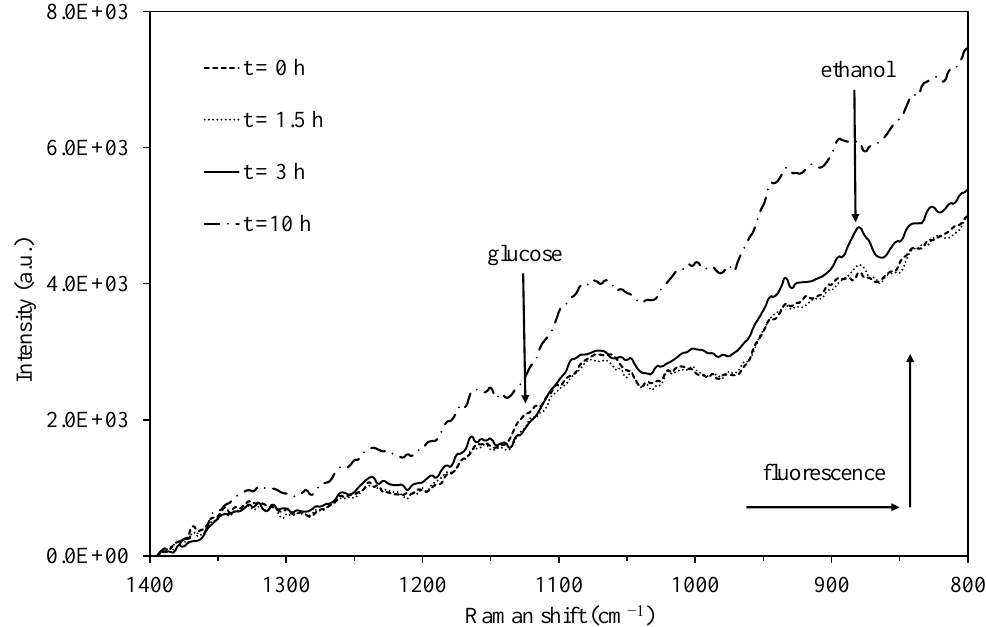
Figure 4. Uncorrected Raman spectra recorded during batch fermentation of S. cerevisiae . The fluorescence background is rising from higher to smaller Raman shifts and is increasing during the yeast fermentation.